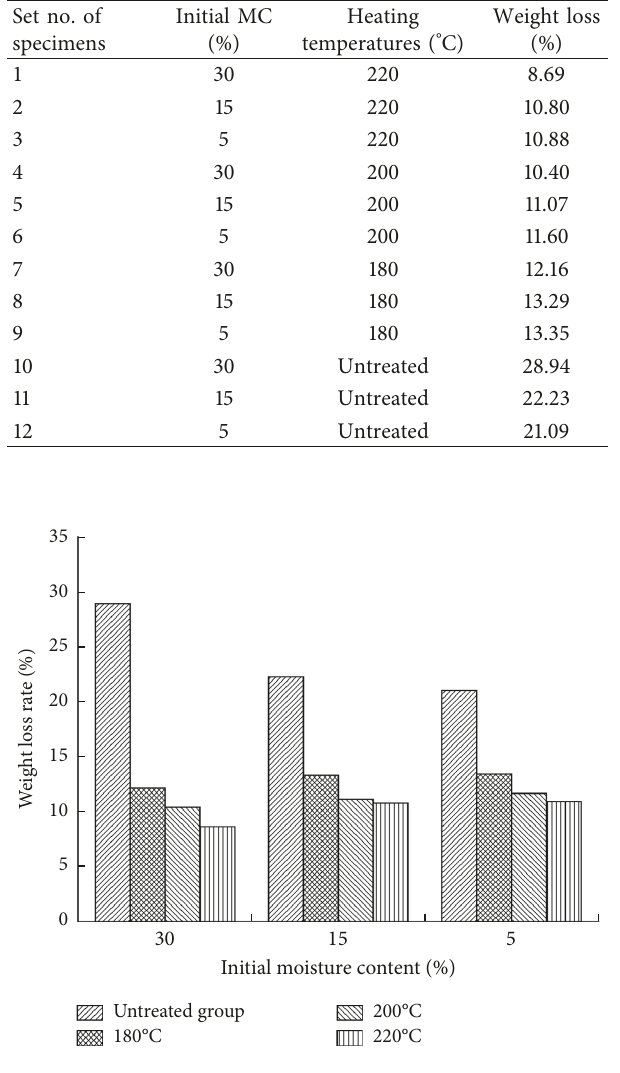
Figure 4: Weight losses of untreated and heat-treated specimens with various initial MC levels and infested by the white rot for 4 weeks.